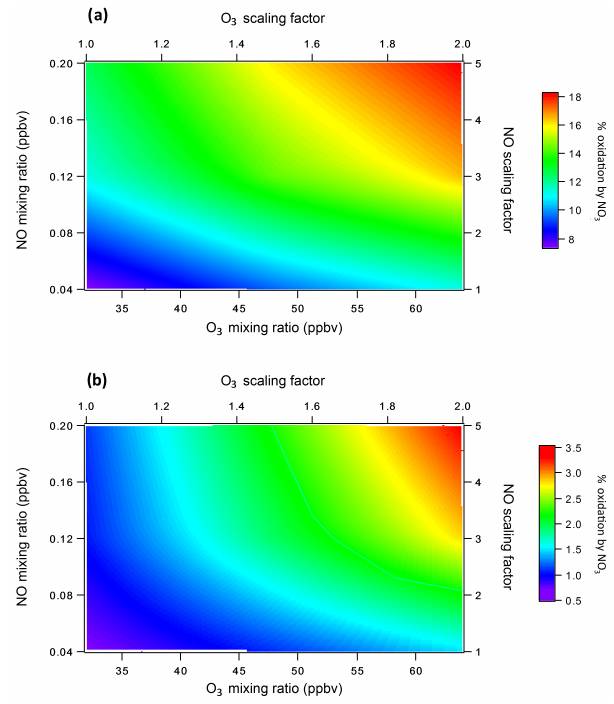
Figure 5. Sensitivity of average fractional oxidation of (a) α -pinene and (b) isoprene by NO 3 below the canopy from 11:00 to 15:00 to changes in O 3 and NO concentrations. The term “scaling fac- tor” specifies changes to the diurnal profiles of O 3 and NO, while “mixing ratios” refer to the resulting average mixing ratios of these species between 11:00 and